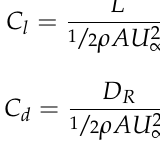
Figure 5. Lift and drag coefficients of the complete aileron with and without GF.